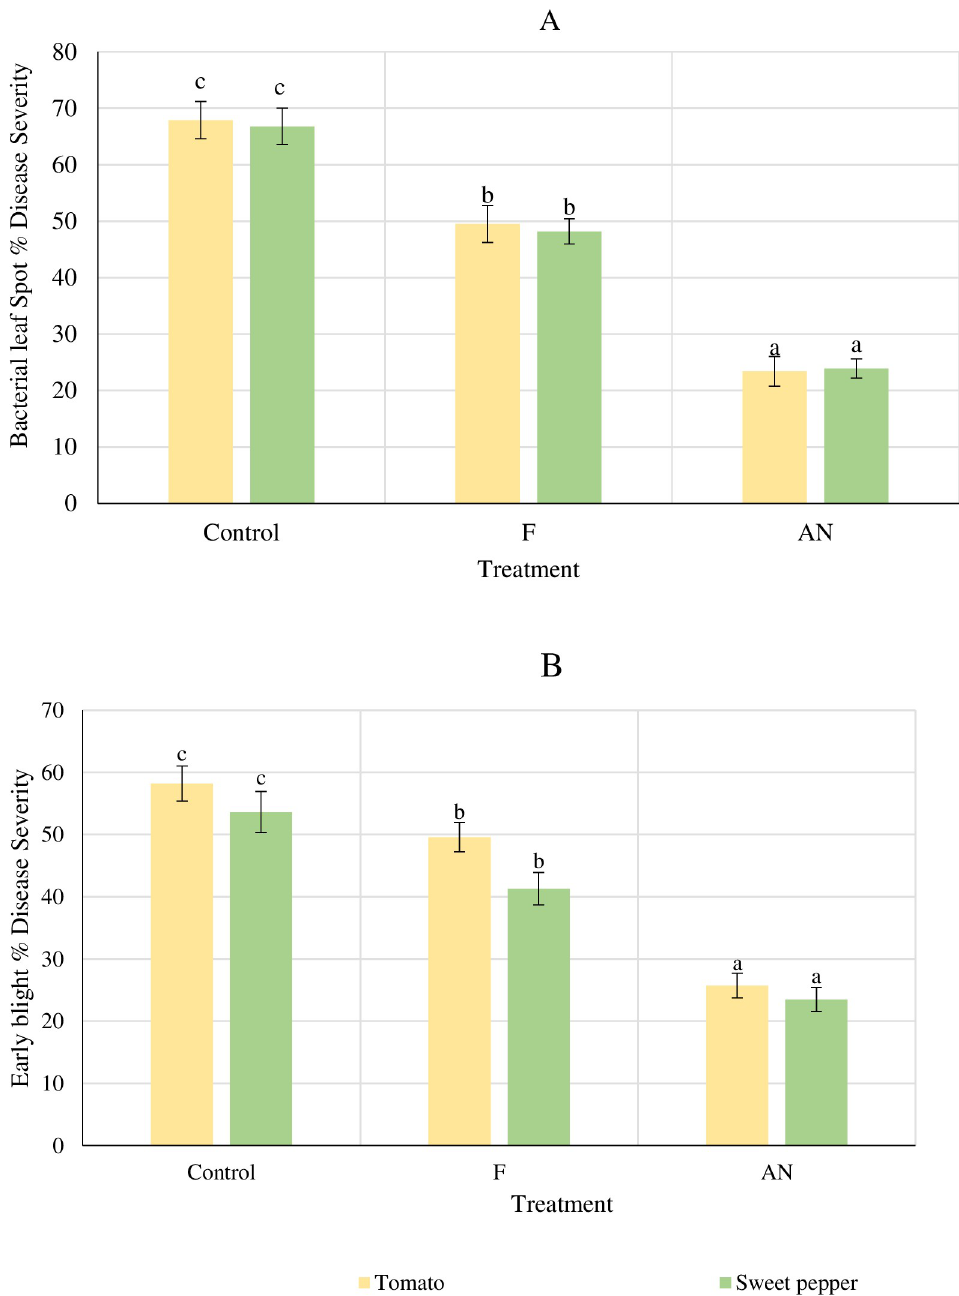
Fig 1. Effect A . nodosum extract on disease severity on greenhouse tomato and sweet pepper plants. A: Xanthomonas campestris pv. vesicatoria ; B: A . solani . Treatments: AN- 0.5% foliar spray; F- Daconex—Chlorothalonil 1.2 g L -1 and Cupraneb; Copper oxychloride 30%+Zineb 10%+Maneb 10% 2 g L -1 ; C- Control. Values are means ± SD of % disease indices on 45 days after infection. n = 60 plants. Bars with different letters represents significant differences ( P = 0.05) according to Fisher’s least significant difference statistical test with vertical bars representing standard deviation. One-way ANOVA was used to compute statistical differences; Tomato ( A . solani ) = 1.0925 E-29 , Tomato ( X . campestris pv. vesicatoria ) = 1.126 E-40 ; Sweet pepper ( A . solani ) = 8.535 E-20 and Sweet pepper ( X . campestris pv. vesicatoria ) = 2.758 E-3